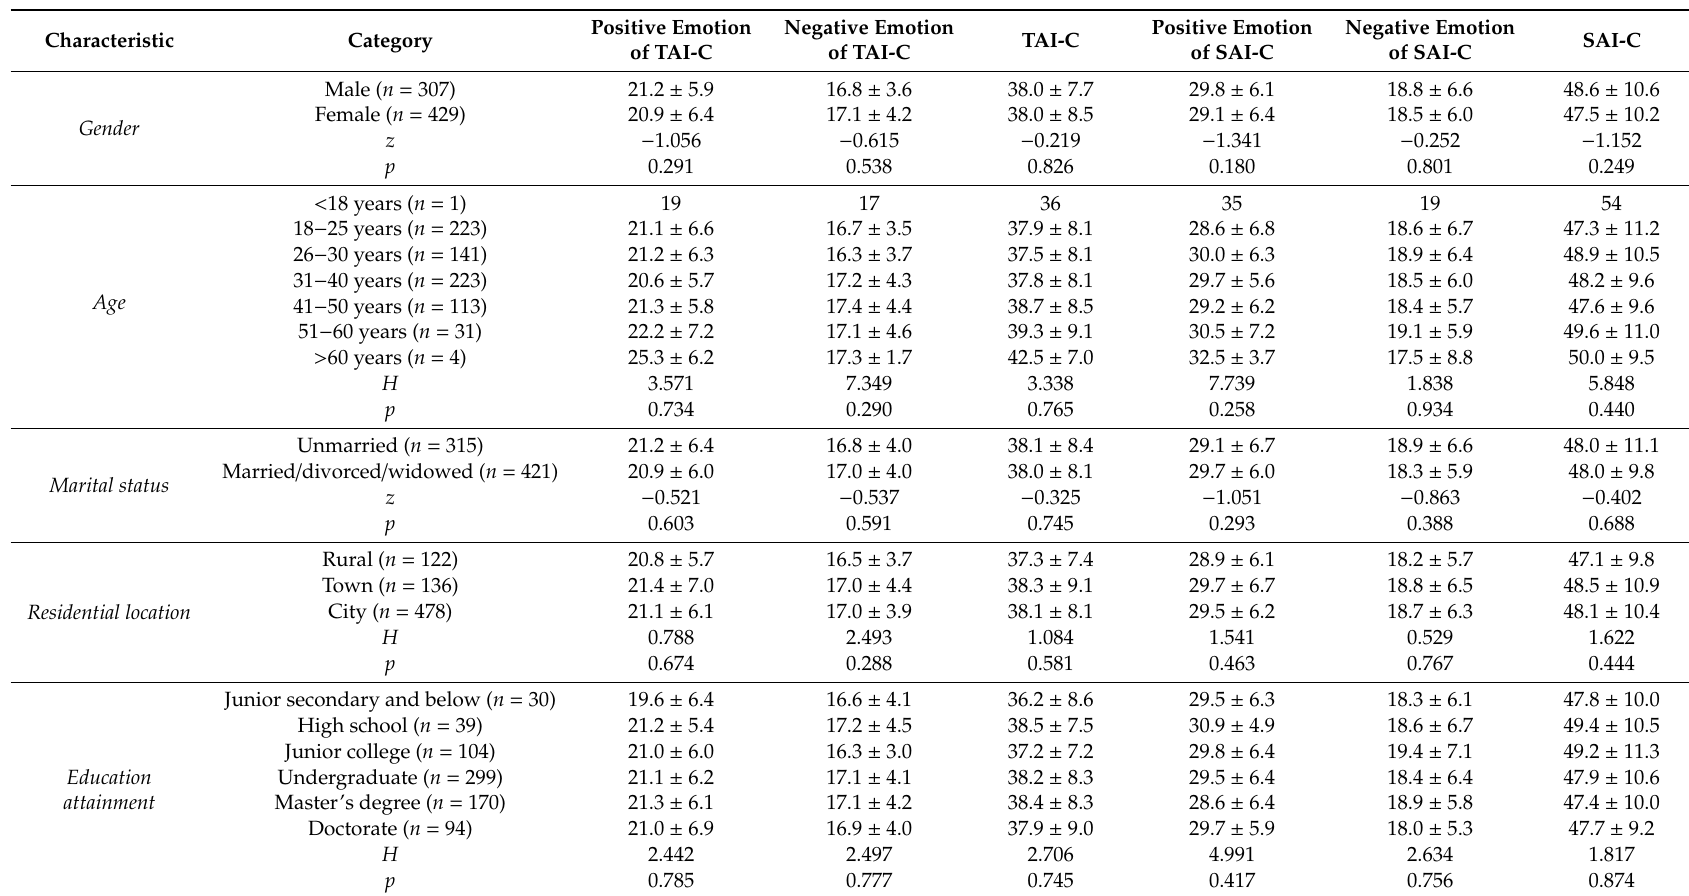
Table 2. Anxiety levels of di ff erent socio-demographic groups ( x ± s